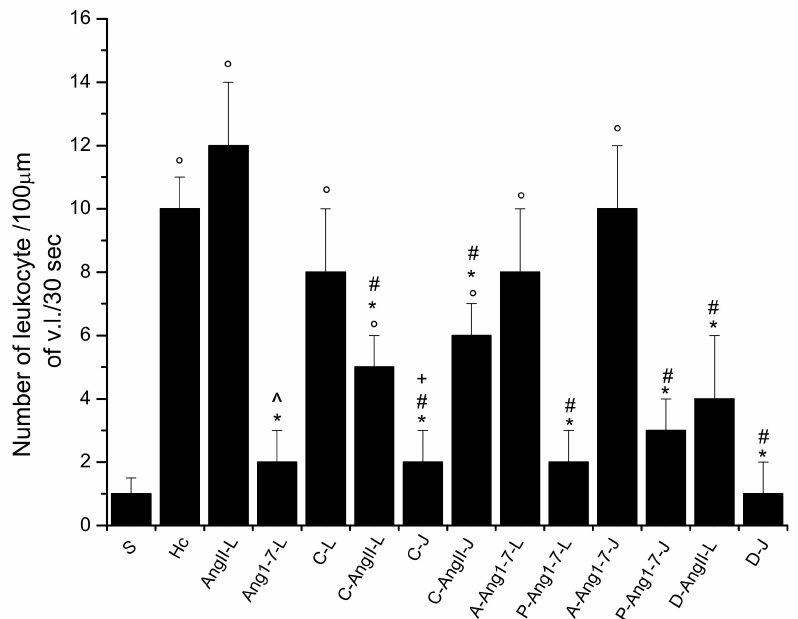
Figure 5. Evaluation of leukocytes sticking to the vessel walls over a 30 sec time period is expressed as the number of adhered cells/100 µ m of venular length (v.l.)/30 sec at the end of reperfusion in the different experimental groups: Sham-operated group (S group), hypoperfused group (Hc group), Ang II local application-treated group (AngII-L group), Ang 1-7 local application-treated group (Ang1-7-L group), candesartan cilexetil local application-treated group (C-L group), candesartan cilexetil plus Ang II local application-treated group (C-AngII-L group), candesartan cilexetil intravenous infusion-treated group (C-J group), candesartan cilexetil local application plus Ang II intravenous infusion-treated group (C-AngII-J group), A779 plus Ang 1-7 local application-treated group (A-Ang1-7-L group), P123319 plus Ang 1-7 local applied-treated group (P-Ang1-7-L group), A779 plus Ang 1-7 intravenous infusion- treated group (A-Ang1-7-J group), P123319 plus Ang 1-7 intravenous infusion-treated group (P-Ang1-7-J group), diminazene aceturate plus Ang II local application-treated group (D-AngII-L group), and diminazene aceturate intravenous infusion-treated group (D-J group). Candesartan cilexetil prior to Ang II administration prevented leukocyte adhesion. Mas receptor antagonist prior to Ang 1-7 did not prevent leukocyte adhesion. Data are reported as mean ± SEM. ◦ p < 0.01 vs. S group, * p < 0.01 vs. Hc group, ˆ p < 0.01 vs. AngII-L group, + p < 0.01 vs. C-L group and # p < 0.01 vs. AngII:L-J groups. Statistical significance was obtained using parametric test (Bonferroni post hoc